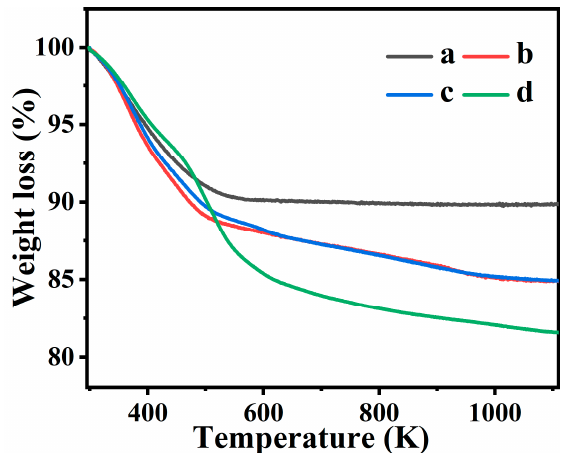
Figure 3. TG profiles of CP ( a ), Fe(0.03) − H(0.05) − CP − 3 ( b ), Fe(0.03) − H(0.05) − CP − 9 ( c ), and Fe(0.03) − H(0.00) − CP − 9 ( d ).